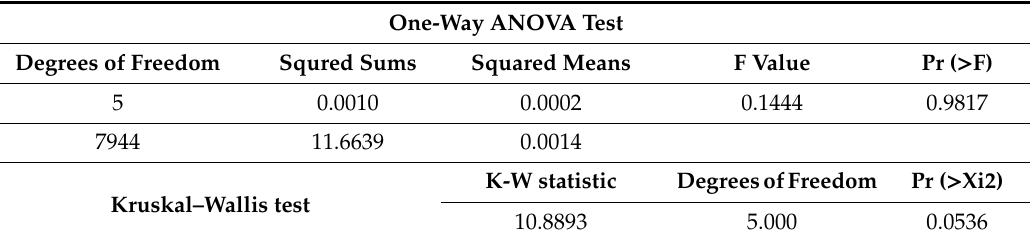
Table 9. ANOVA and Kruskal–Wallis test of the observed weekly returns in the simulated portfolios of the NATGAS price and the USTBILL portfolio.